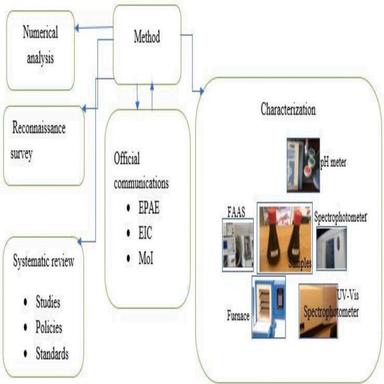
Simplified diagrammatic look of the methods and materials applied in the current study.